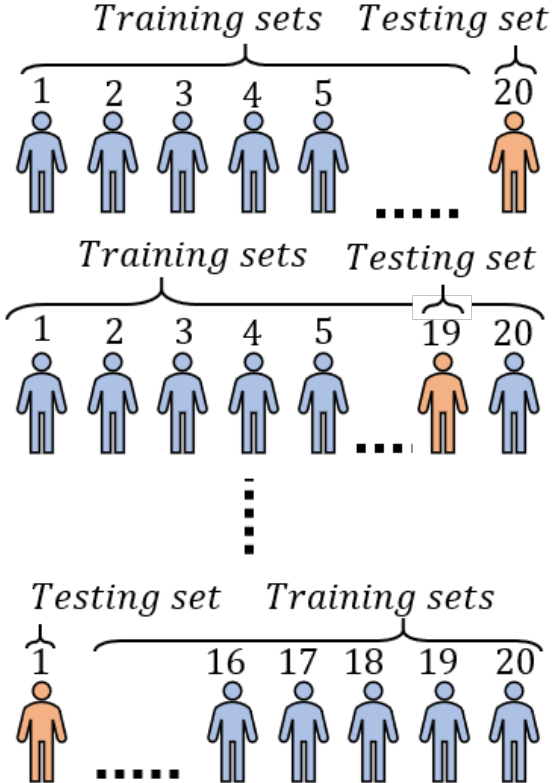
Figure 4. A representation of leave-one-out cross validation for a model using the 20 volun- teers’